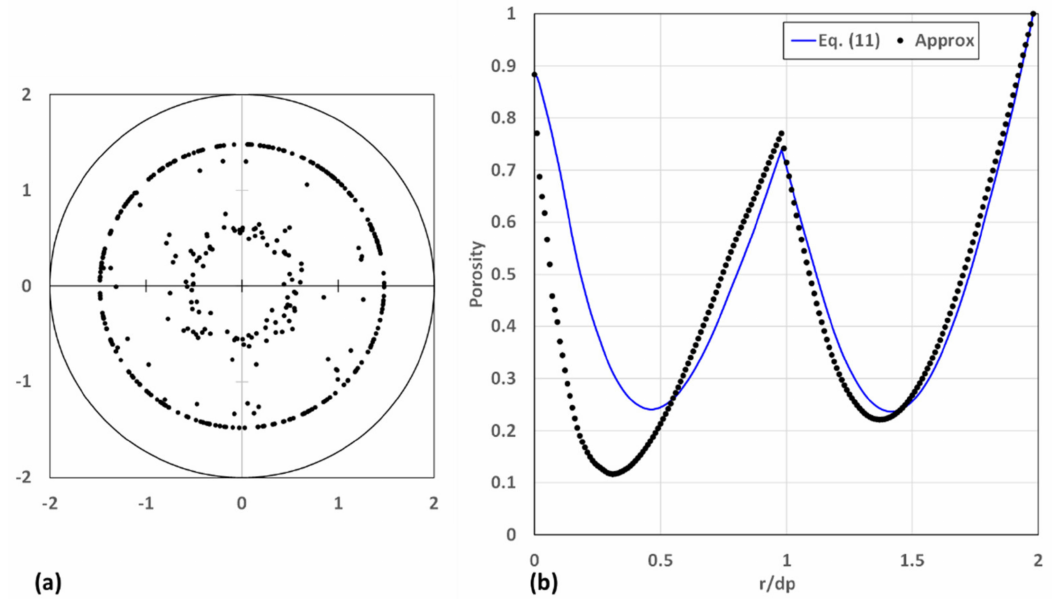
Figure 7. ( a ) Positions of centres of the spheres and ( b ) the radial variations in porosity based on Equation (11) and the approximate expression for D / d p =